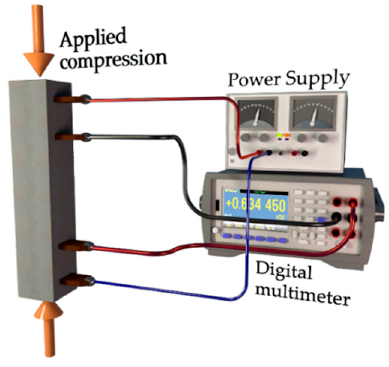
Figure 3. The experimental setup used to measure changes of the electrical resistivity in mortar samples subjected to compression load.